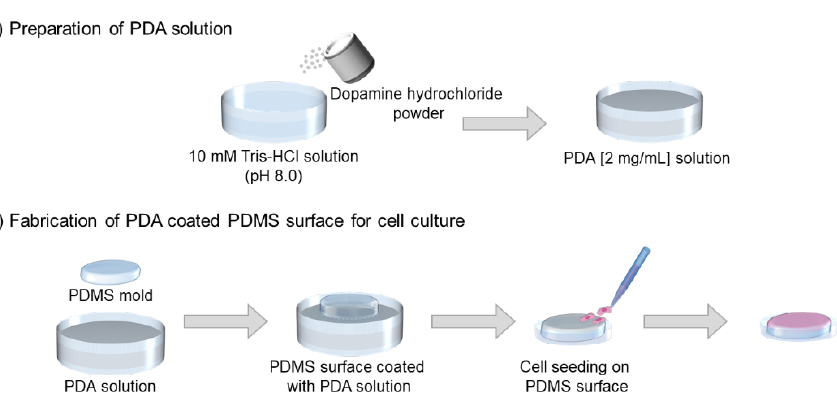
Figure 1. Schematic illustration showing the fabrication of a PDA-coated PDMS surface. ( a ) Prepa- ration of the PDA solution and ( b ) application of PDA coating to the PDMS surface followed by cell